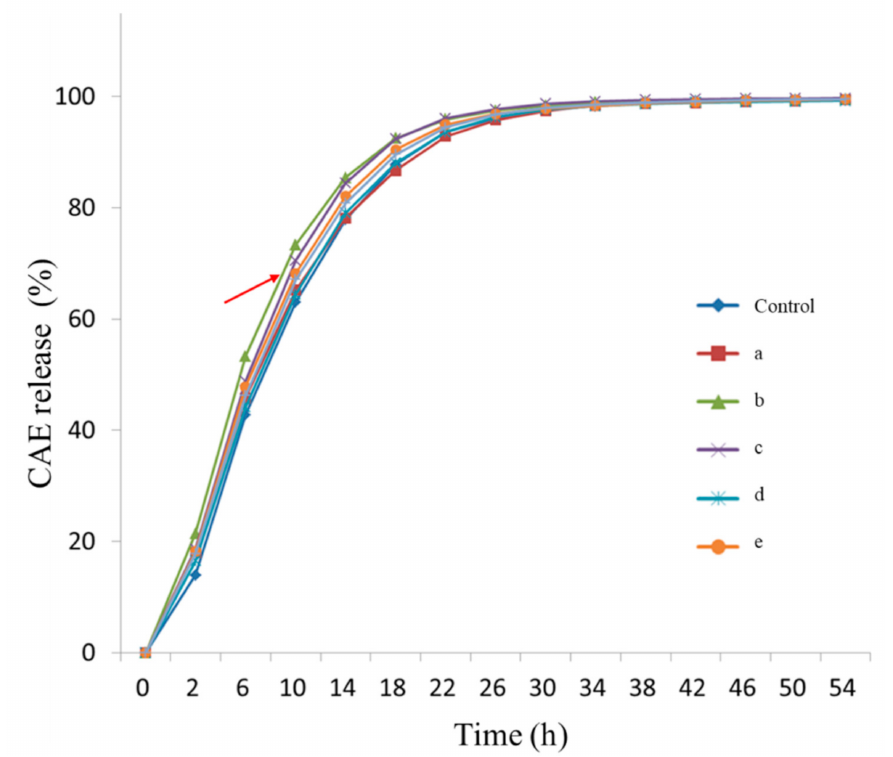
Figure 7. Centella asiatica extract (CAE) release profile of CAE-loaded hyaluronic acid-dextran (HA-Dex) hybrid hydrogel patches. Control: HA-Dex hybrid hydrogel patches with no CAE; (a) 9.8:0.2 HA-Dex: CAE; (b) 9.6:0.4 HA-Dex: CAE; (c) 9.4:0.6 HA-Dex: CAE; (d) 9.2:0.8 HA-Dex: CAE; (e) 9:1 HA-Dex: